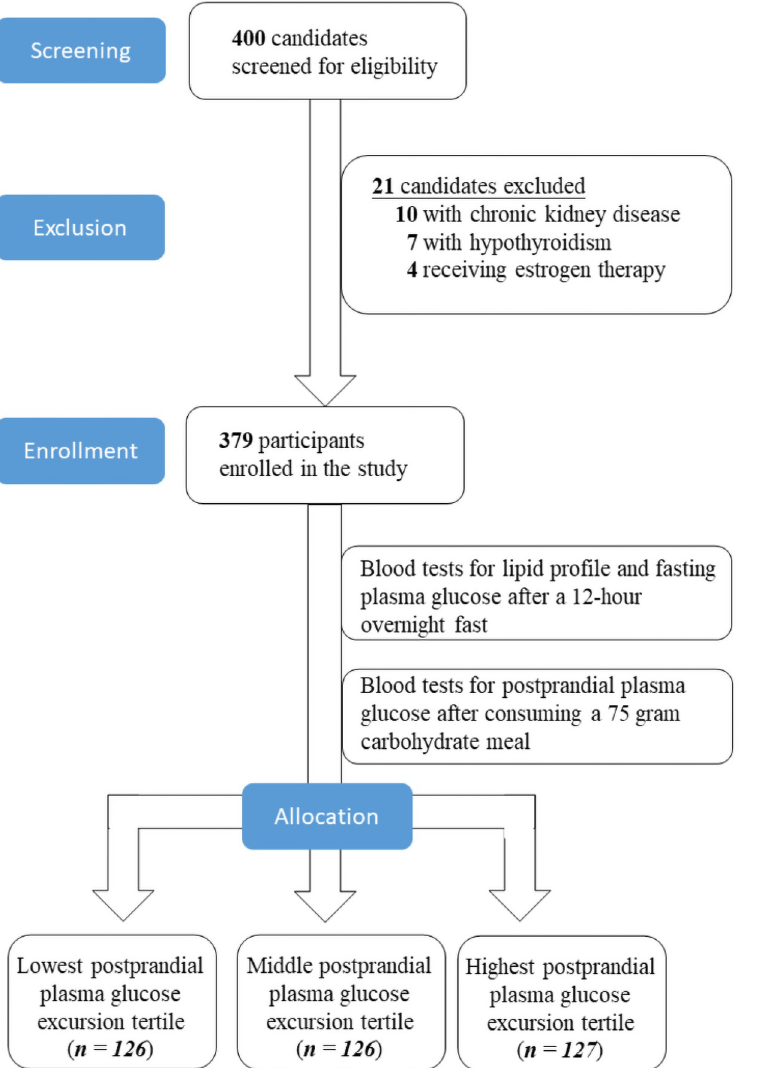
Fig 1. Enrolment protocol of the